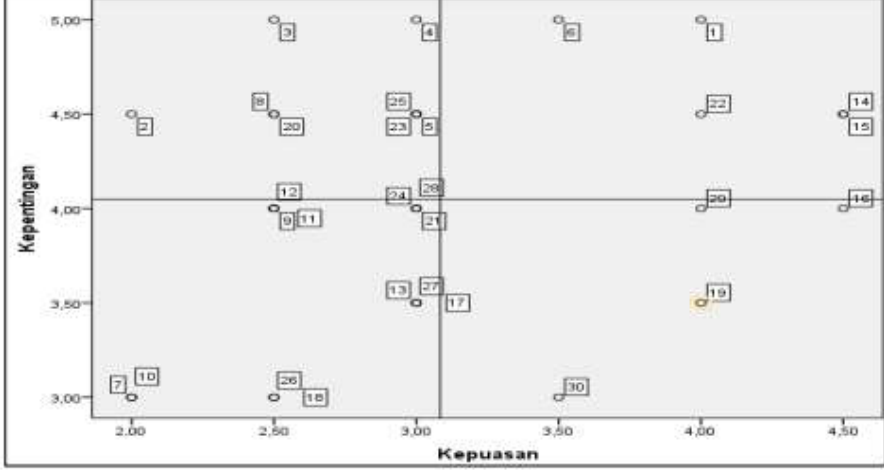
Figure 2. Importance Performance Analysis Results of the South Pacific Source: Processed,